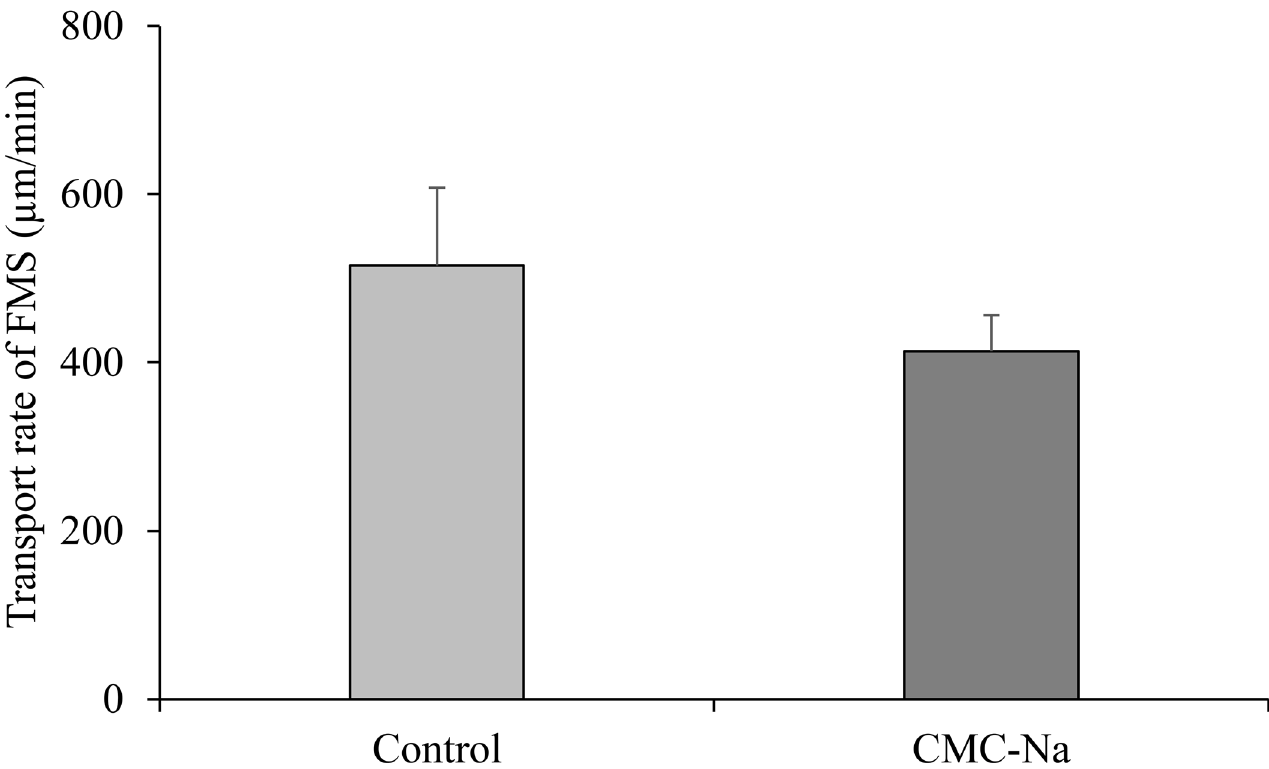
Fig 5. The effect of CMC-Na on the mucociliary clearance after nasal administration of the powder containing CMC-Na. Results are expressed as the mean ± S.E. of at least three experiments.